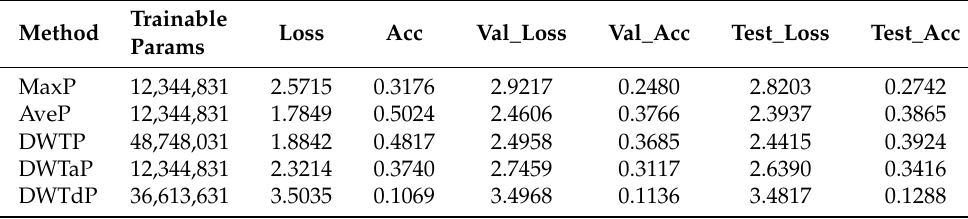
Table 4. Performance of pooling methods on DTD - SGD